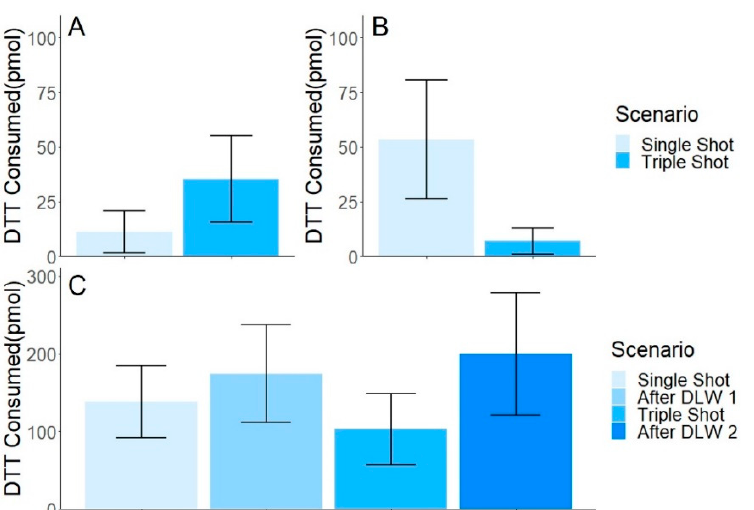
Figure 6. Oxidative Potential. DTT consumption and SEM (pmol) are shown for the filters ( A ), DST ( B ), and hand swab samples ( C ). No significant differences were detected during statistical analysis using a Welch’s t -test (filters and DST) and one-way ANOVA (hand swabs) with p -values of ≤ 0.05 considered significant.